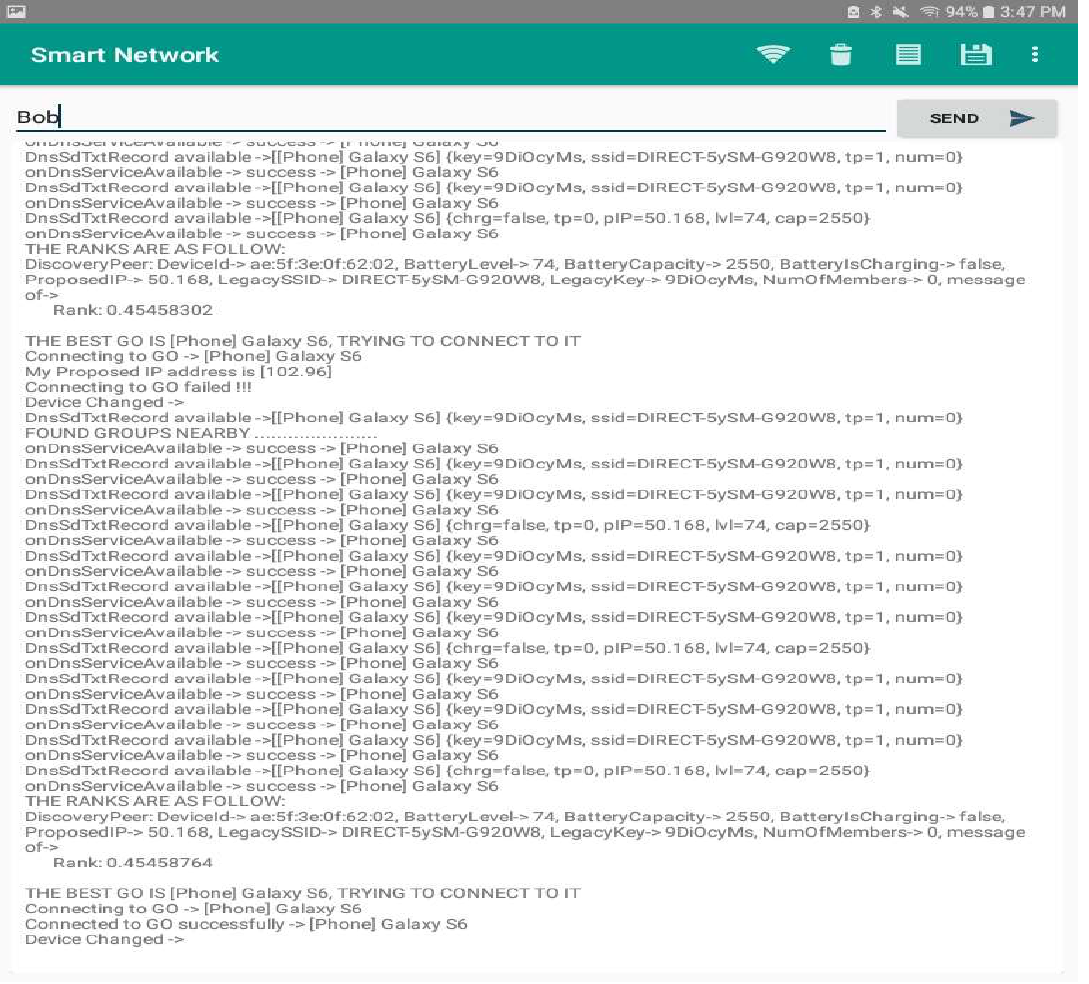
Figure 6. Application interfaces used on devices.